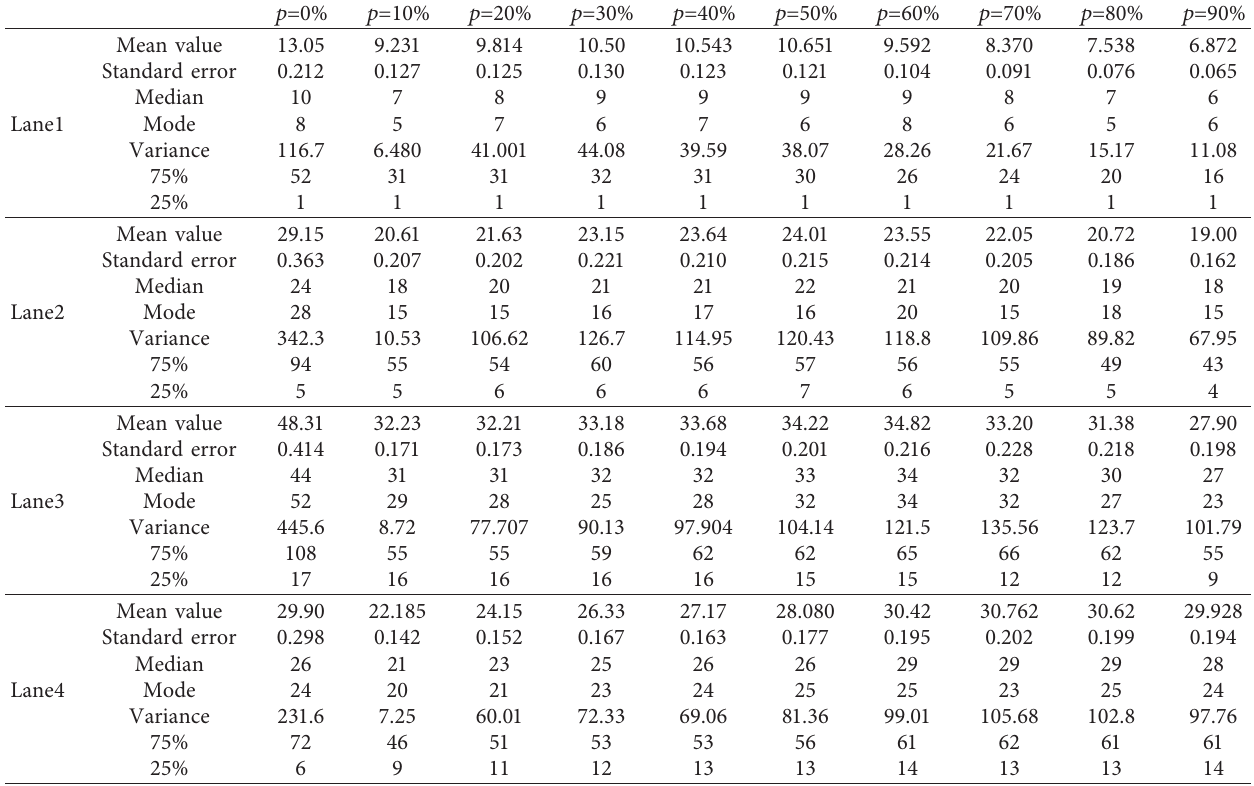
Table 4: The statistical description table of the rate of changing into lanes of each lane under different autonomous vehicle penetration rates. p �